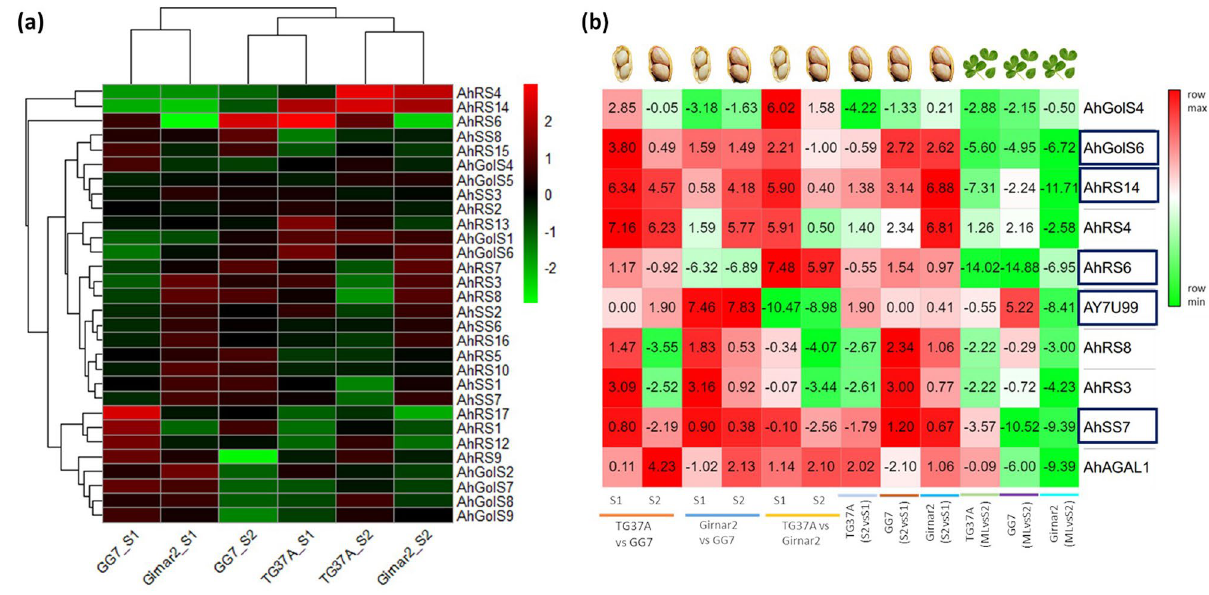
Figure 5. Expression profile of differentially expressed genes related to RFOs biosynthesis across the varieties and seed stages. (a) Global heatmap of RFOs genes. Upregulation and downregulation is indicated by the intensity of red and green respectively. FPKM values have been used for designing the heatmap. The figure has been created using ‘gplots’ package 3.1.1 version of the R software. (b) Heatmap of log2 fold change values across various combinations. The name of genes is represented on Y-axis and X-axis represents varieties and stages. The figure has been created using Morpheus web tool (https:// softw are. broad insti tute. org/ morph